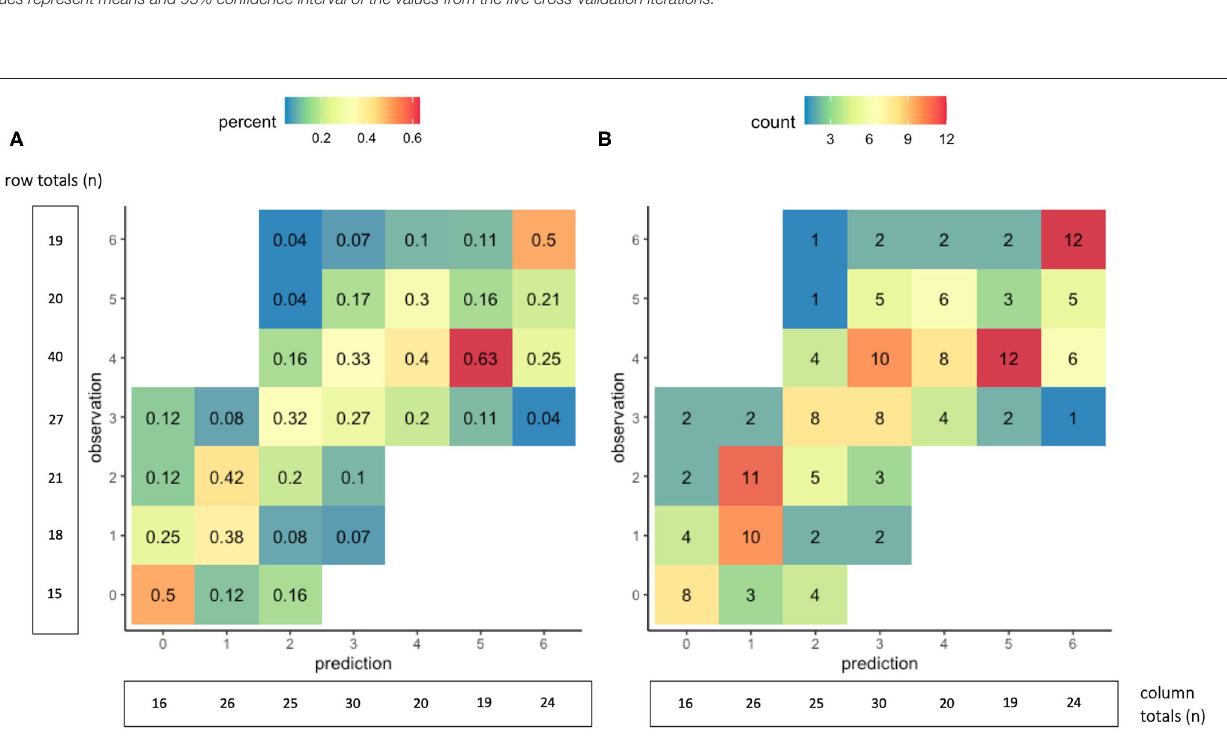
current models is that few models are externally validated